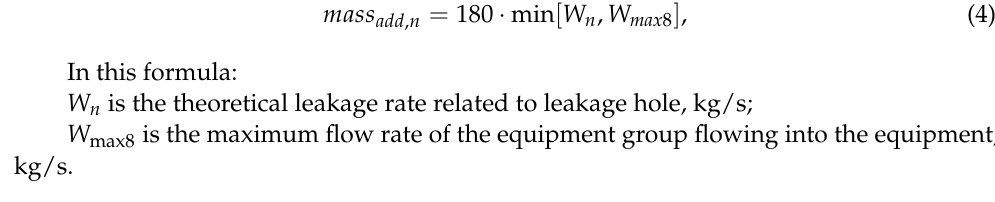
Table 3. Assumptions for calculating the liquid inventory in the equipment.